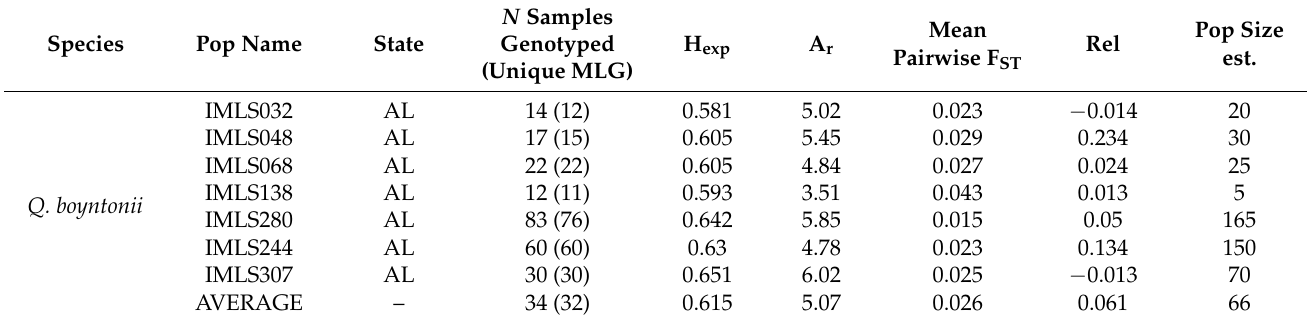
Table 2. Summary statistics for each population and the average across populations. Reported is the population name (Pop name), the state the population is located (State, specific locality data is not provided given the rarity of the species), the number of samples ( N samples genotyped) and number of unique multilocus genotypes (unique MLG), the expected heterozygosity (H exp ), allelic richness (A r ), mean pairwise F ST , relatedness (Rel), and estimated number of trees based on direct observations in the field (Pop size